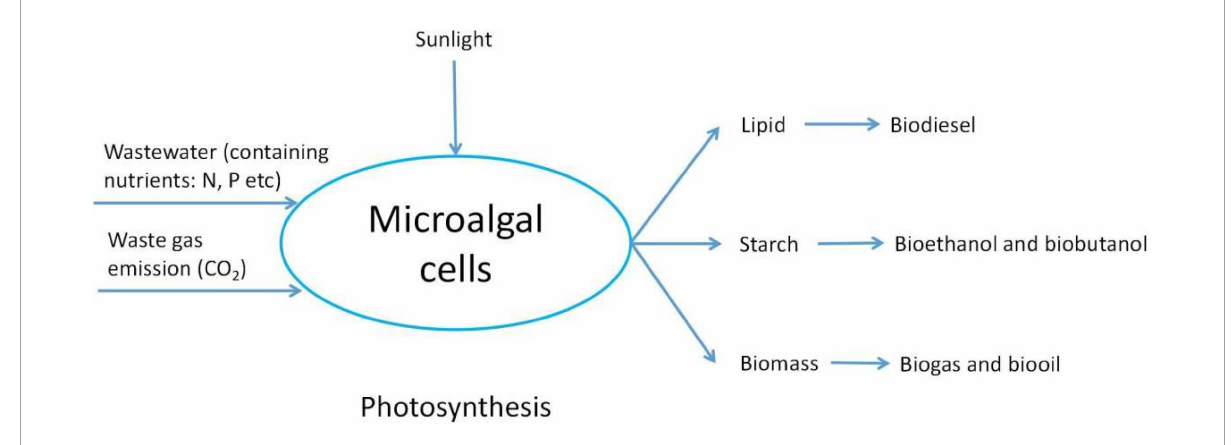
FIGURE4 Schematic of biomass energy production from microalgae.